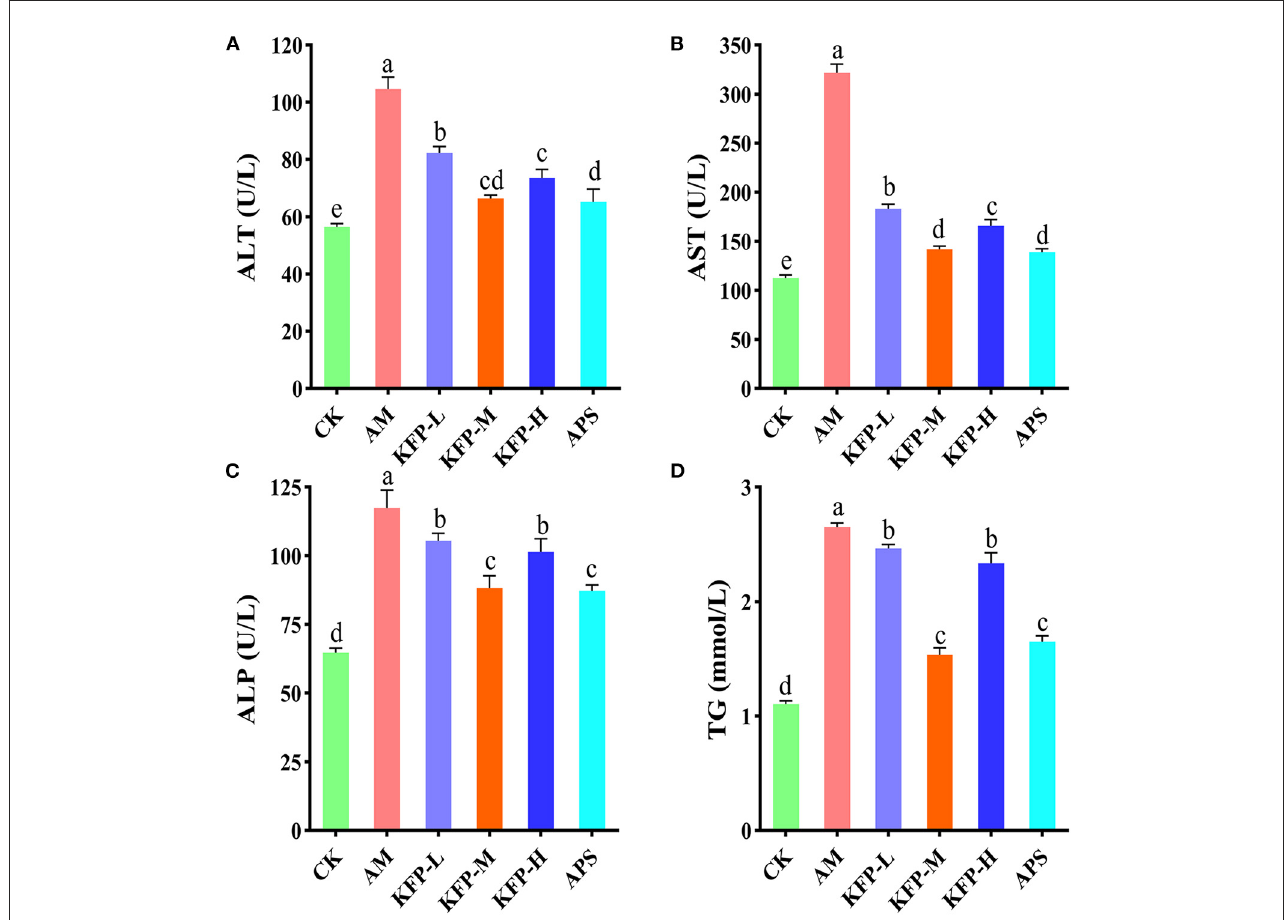
FIGURE2 The effects of KFP on serum AST, ALT, ALP and TG in AA-induced mice. (A) ALT, (B) AST, (C) ALP, (D) TG. The data are represented as mean ± SD ( n = 10). Different letters indicate significant differences between groups, whereas the same letters indicate no significant differences. a,b,c,d p < 0.05. CK, control group; AM, acrylamide model group; KFP-L, low-dose KFP group; KFP-M, medium-dose KFP group; KFP-H, high-dose KFP group; APS, Astragalus polysaccharide positive